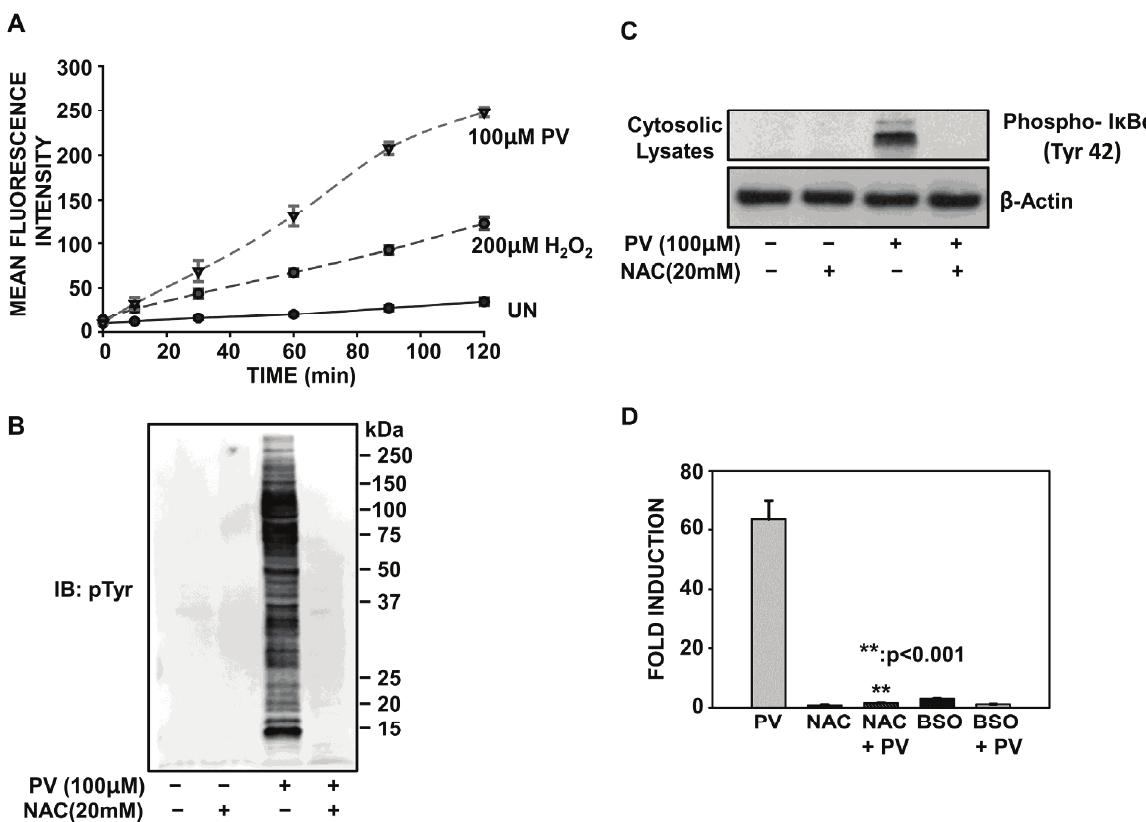
Figure 4. PV-mediated activation of NF-(cid:2)B involves oxidative stress. ( A ) ILU-18 cells were washed and briefly incubated in 1X Hank’s Balanced Salt Solution (HBSS), prior to incubation with 10 (cid:4)M H 2 DCF-DA for 30 min at 37 °C in the dark. At the end of the incubation, cells were washed and resuspended in 1X HBSS. Intracellular reactive oxygen species (ROS) generation was detected following addition of PV (100 μM) or H 2 O 2 (200 μM), as described in the methods section. ( B ) ILU-18 cells were either untreated or treated with NAC (20 mM) for 2 h. After media replacement, cells were selectively treated with PV (100 (cid:4)M) for 20 min. At the end of incubation, cells were washed and cytosolic lysates prepared. As controls, cell lysates were made from ILU-18 cells left untreated or treated with 20 mM NAC alone for 140 min. Lysates, equalized for 30 (cid:4)g protein, were resolved using SDS-PAGE, followed by Western blotting using an antibody specific to Phospho-Tyrosine residues. Molecular weights derived from standards are indicated in kDa. ( C ) Cytosolic lysates (30 μg), obtained as in (B), were resolved using SDS-PAGE, followed by Western blotting using a phospho-specific antibody recognizing I(cid:2)B(cid:3) (Tyr-42). After stripping, the blot was re-probed with antibody to (cid:5)-actin to demonstrate equal protein loading. ( D ) ILU-18 cells were either untreated or treated with NAC (20 mM) for 2 h. After media replacement, cells were selectively treated with PV (100 (cid:4)M) for 18 h. Additionally, ILU-18 cells were treated with 100 (cid:4)M H 2 O 2 for 18 h or subjected to treatment with 200 (cid:4)M BSO for 24 h. Lysates obtained were evaluated for luciferase acitivity, as described previously. Data obtained from at least four independent experiments are presented; values represent data means ± standard error. ** Denotes significant difference at p < 0.001, between treatment